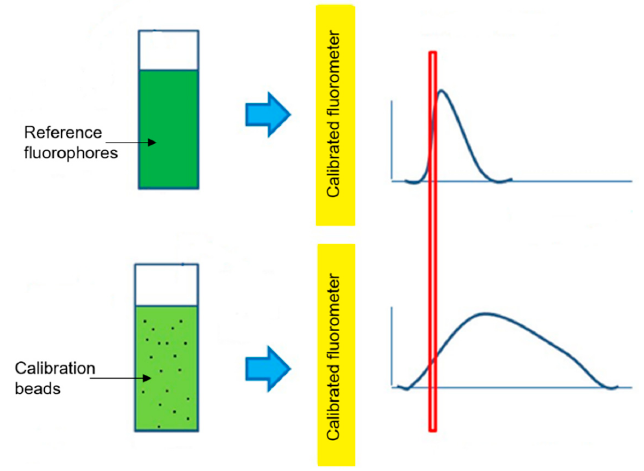
Figure 5. Schematic for measuring the fluorescence emission spectra of both reference fluorophore solutions and a calibration bead suspension using a calibrated fluorescence spectrometer (fluorometer) to determine the integrated fluorescence intensity of the bead suspension. The red rectangle shows the spectral range, defined by the emission bandpass filter of the fluorescence channel of a flow cytometer, over which the fluorescence spectra are integrated.